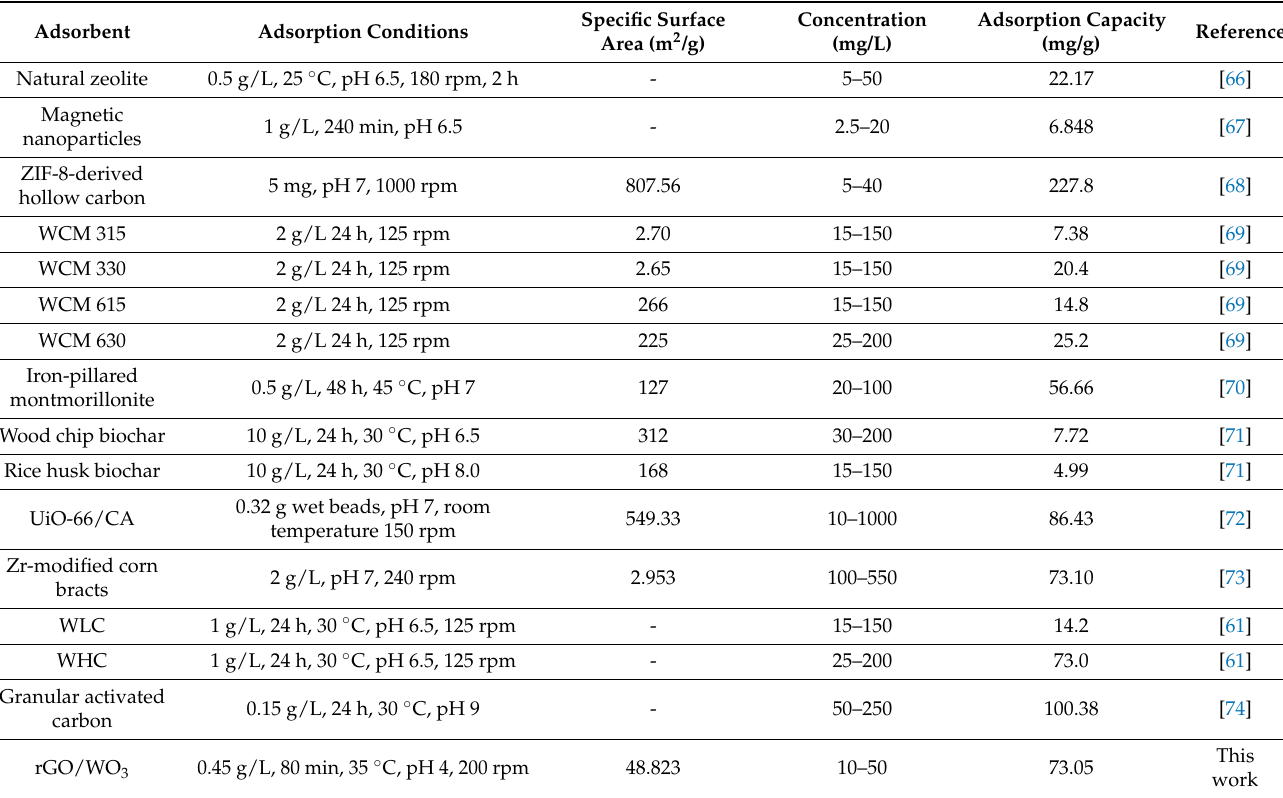
Table 4. Comparison of the present work with the reported literature for the adsorption of